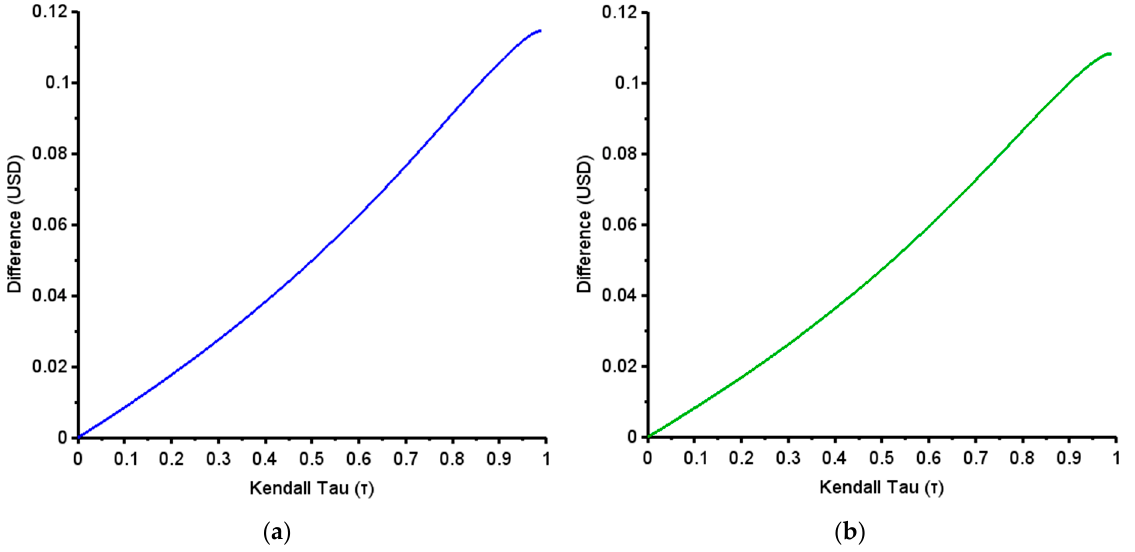
Figure 6. The difference between the zero-coupon MECB prices that involve and do not involve the trigger event correlation rate for each τ ∈ [ 0,1 ) ( a ) and the difference between the coupon-paying MECB prices that involve and do not involve the trigger event correlation rate for each τ ∈ [ 0,1 ) ( b ).